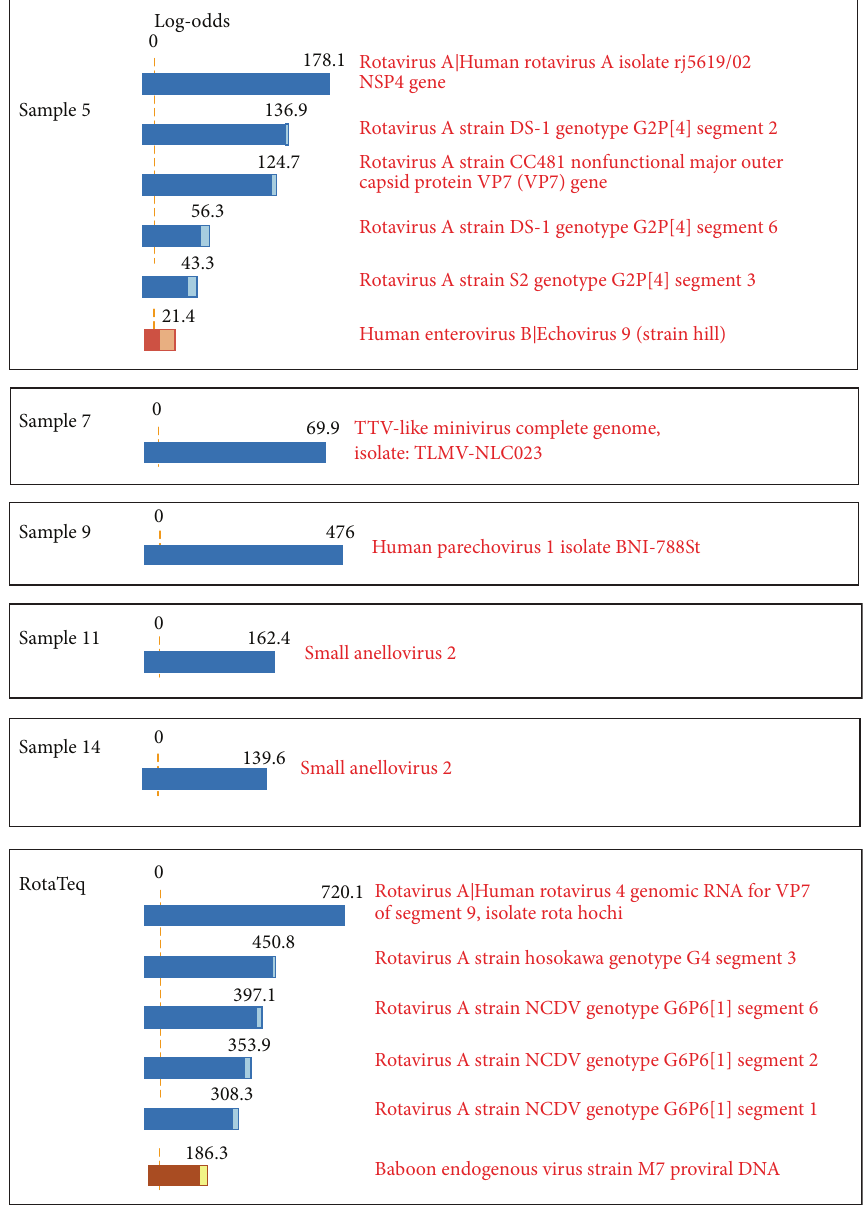
Figure 1: LLMDA viral results from human ileum samples and RotaTeq. Microarray data were analyzed using the composite likelihood maximization method developed at Lawrence Livermore National Laboratory [28]. The log likelihood for each of the possible targets is estimated from the BLAST similarity scores of the probe and target sequences, together with the probe sequence complexity and other covariates derived from the BLAST results